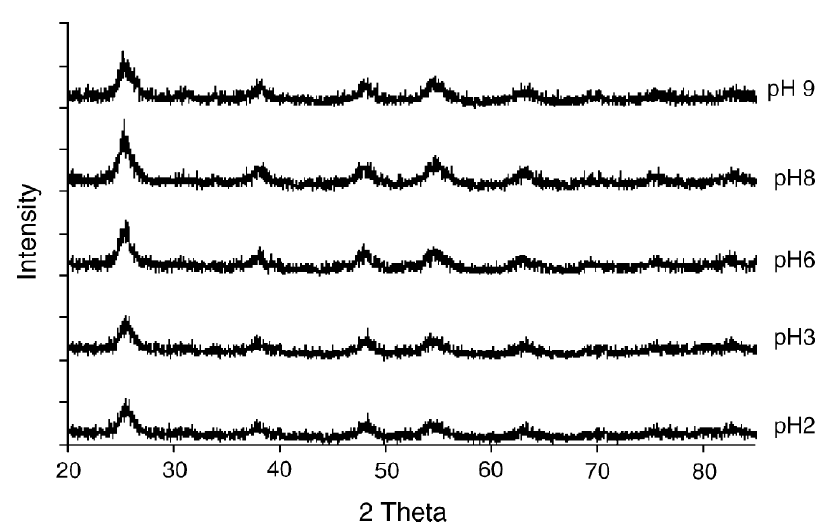
Figure 6. XRD patterns of pure TiO 2 obtained at different pH values, with HNO 3 (pH < 7) or NH 4 OH (pH > 7) peptizing agent, from [38] (reproduced with permission from S. Mahshid et al., Journal of Materials Processing Technology; published by Elsevier, 2007).